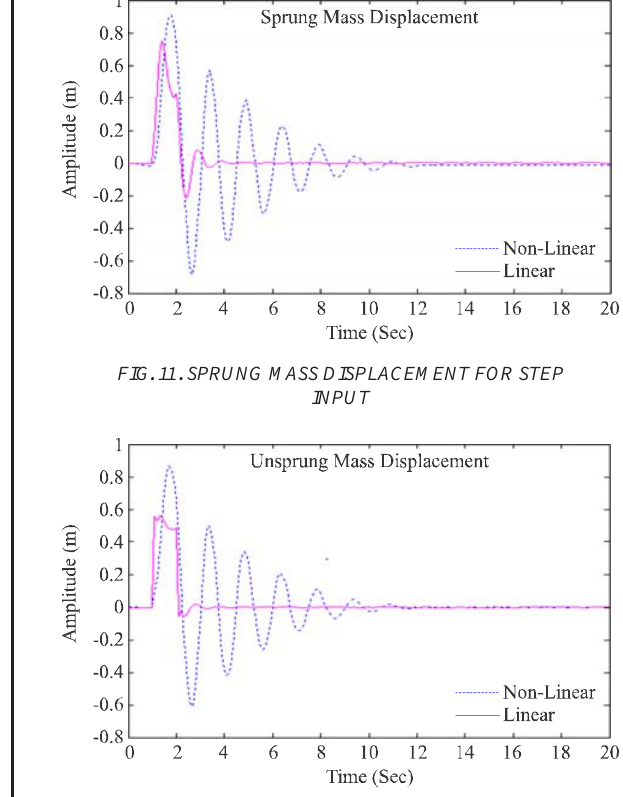
FIG. 10. UNSPRUNG MASS DISPLACEMENT FOR LINEAR AND NON-LINEAR SYSTEM